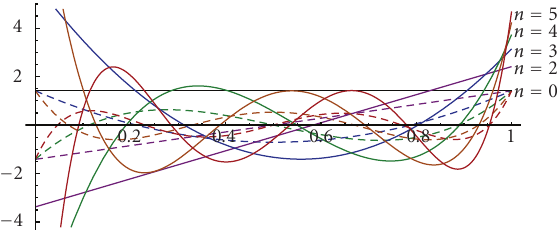
Figure 4: The one-dimensional tetrahedral polynomials q n ( k ) on the domain (23), rescaled to the unit interval for n = 0 − 5. Also plotted are the shifted Legendre polynomials P n (2 x − 1) (dashed lines) which share qualitative features such as n nodal